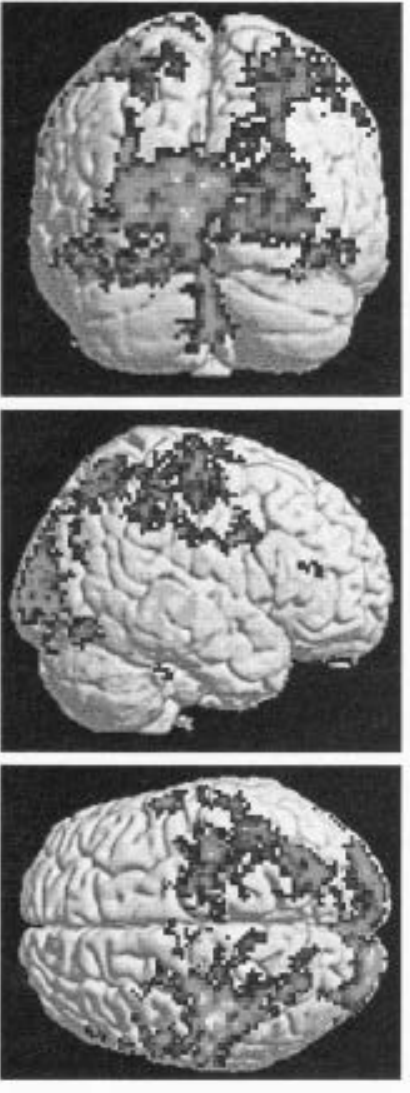
Figure 1 Positron emission tomography (PET) scans of brain activation during experimental Oldowan toolmaking. Successful flaking requires the precise delivery of powerful blows, as well as the identification of appropriate targets based on visual assessment of the core. These demands are reflected in the activation of motor planning and execution regions in the posterior frontal lobe, seen in the mid­ dle of the brain in the central (right lateral) and lower (dorsal) images, and of higher­ order visual cortex in the occipital and posterior parietal regions, as can be seen towards the back of the brain in the upper (posterior)